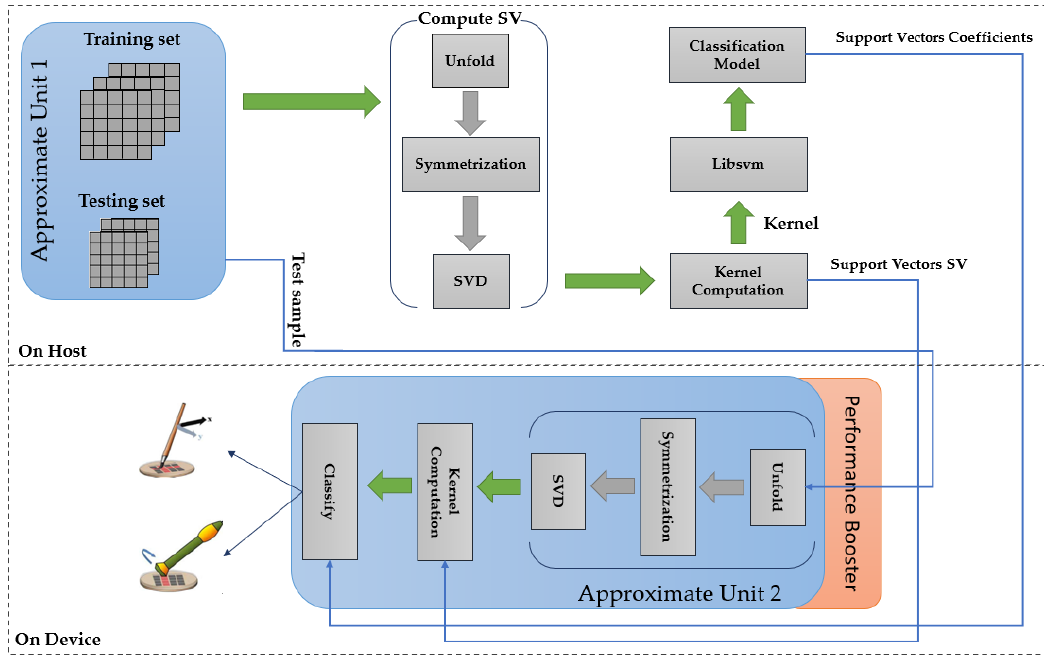
Figure 2. Sketch of the proposed Approximate Tensorial